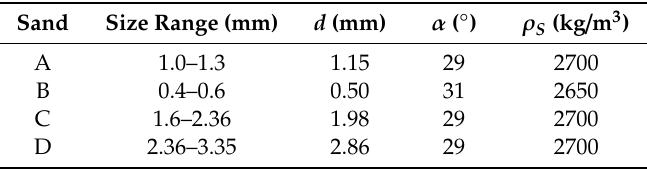
Table 1. Sediment Table 1. Sediment properties.